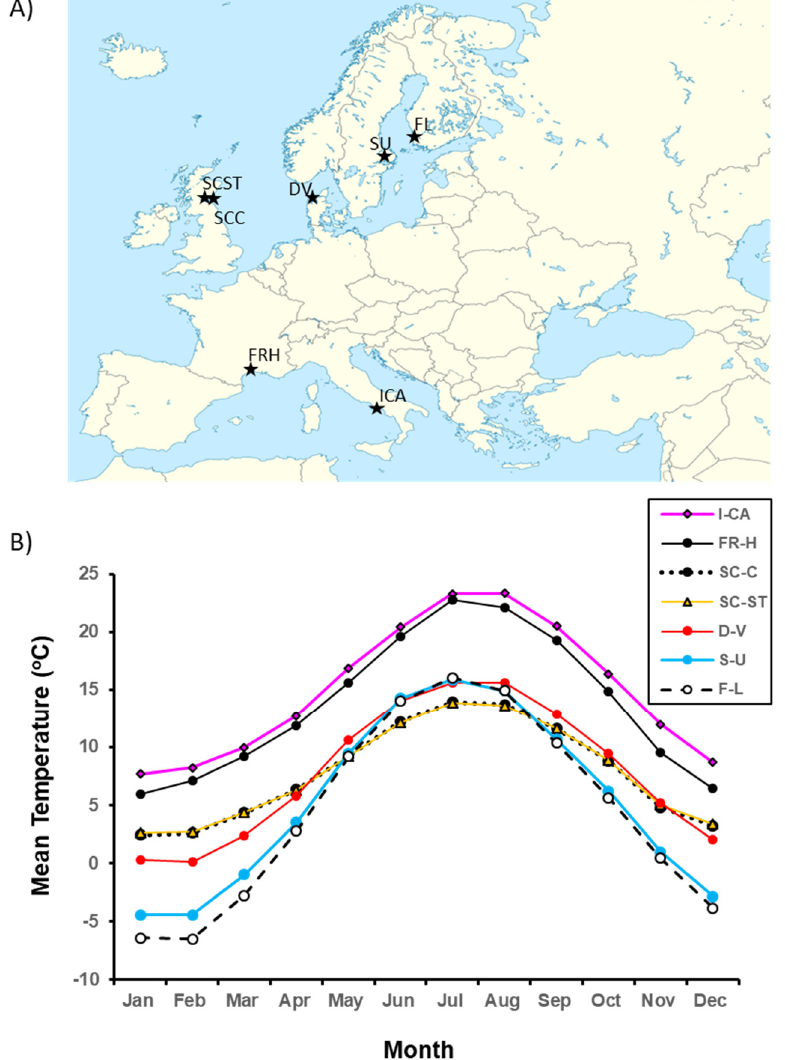
Figure 4. ( A ) Locations of original field populations from which the experimental genotypes were descended. Veno, Denmark (DV); Lund, Finland (FL); Cupar, Scotland (SCC); St. Andrews, Scotland (SCST); Upsala, Sweden (SU); Hameau de St. Felix, France (FRH); Castel Volturno, Italy (ICA). ( B ) Estimated 30-year mean monthly temperatures for the seven source populations (See Lacey et al., 2010 [106] for determination method).